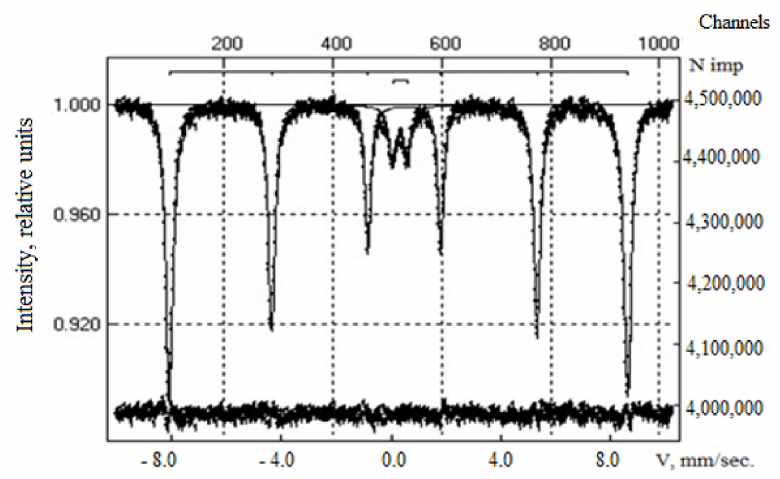
Figure 9. Mössbauer spectrum of CoFe 2 O 4 .